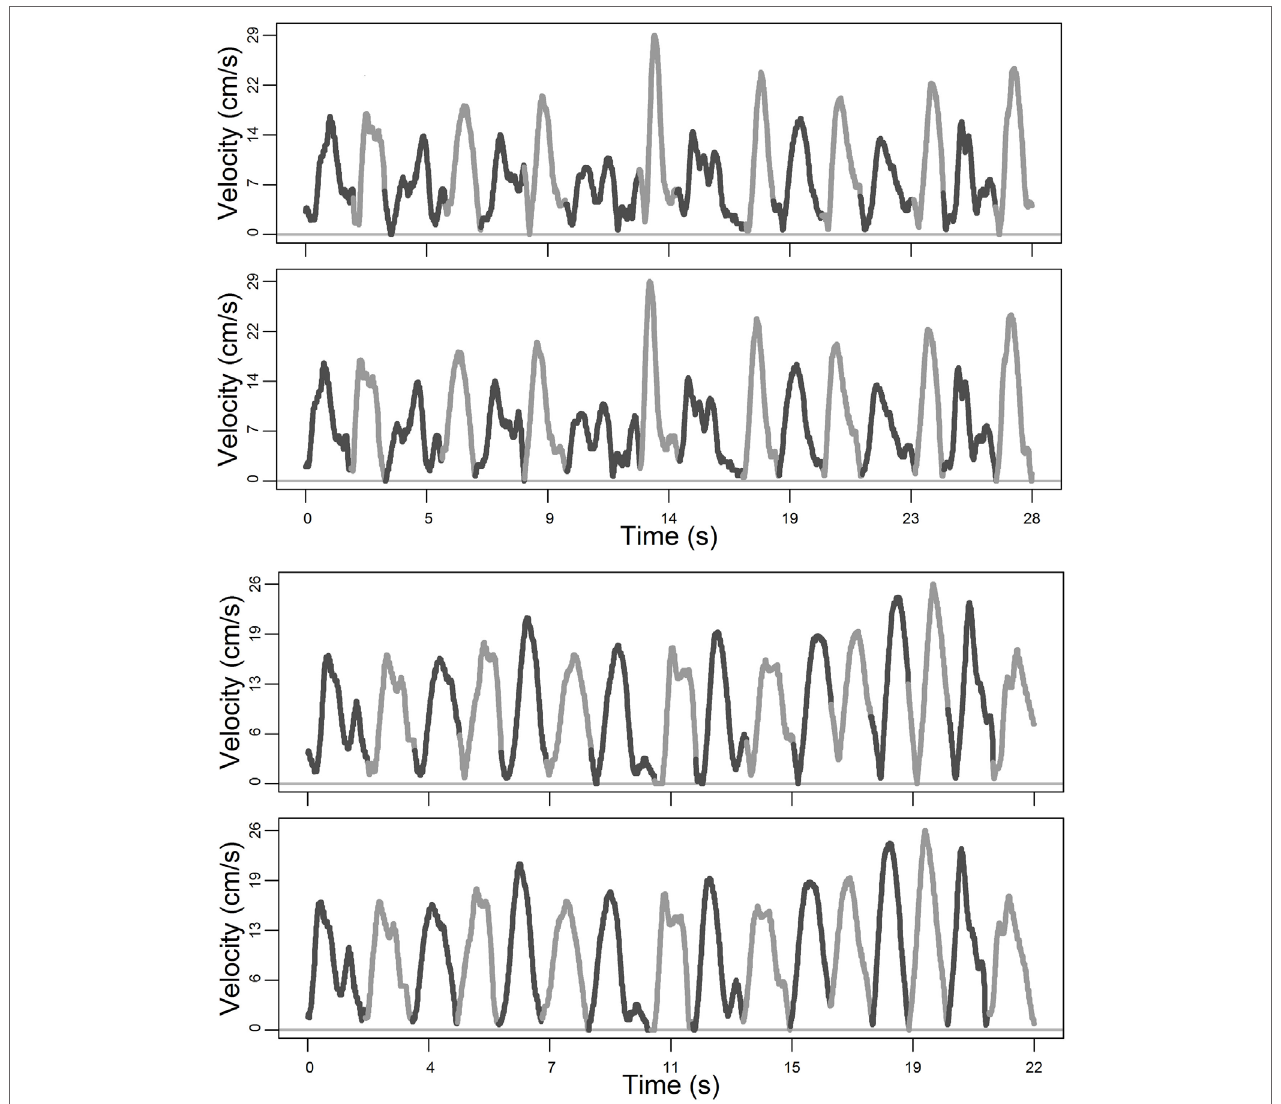
FiguRe 4 | Exemplars of complete target cycles: 16 movements each. Top panels show movement cycles as partitioned by the robot; bottom panels show movement cycles conditioned post hoc : all boundaries coincide with local